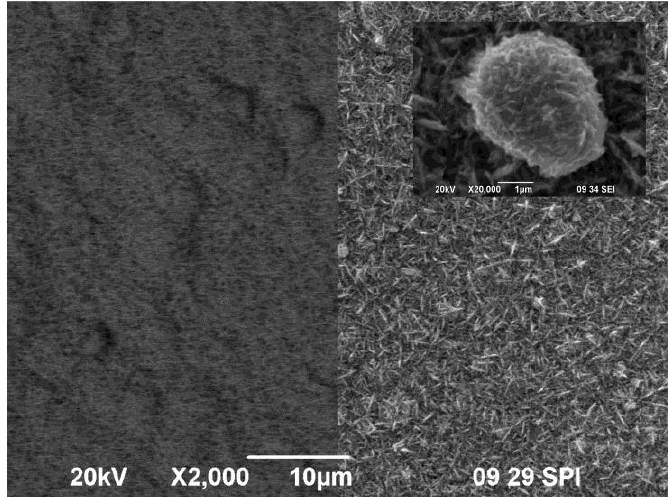
Figure 3. Surface morphology of zinc–carbon sphere coating on steel. Inset: carbon sphere at high magnification.